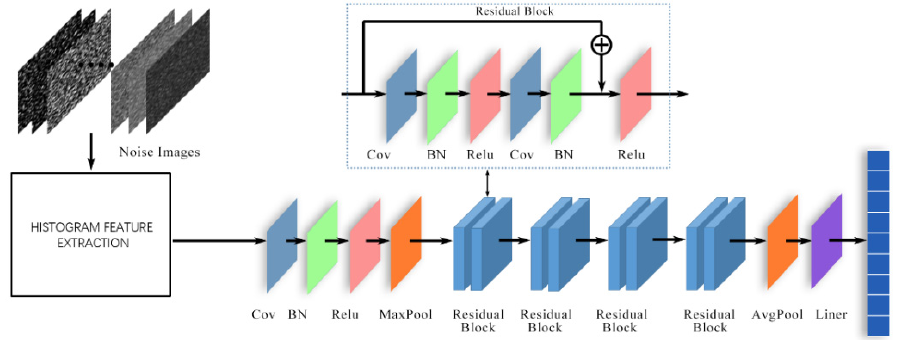
Figure 1. Residual network model for noise classification.